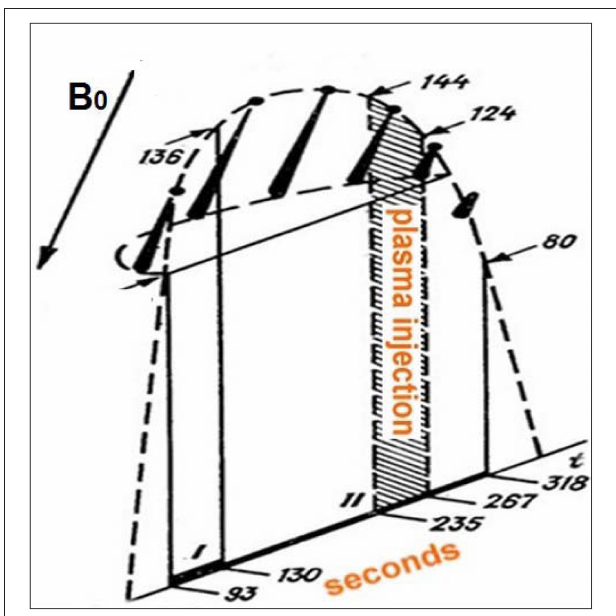
FIGURE 3 | Cartoon depicting the Zarnitza-2 rocket trajectory with electron and plasma injections. The numbers 136, ...80 indicate the altitude in kilometers. After Dokukin et al. (1981). Reprinted by permission from COSPAR.